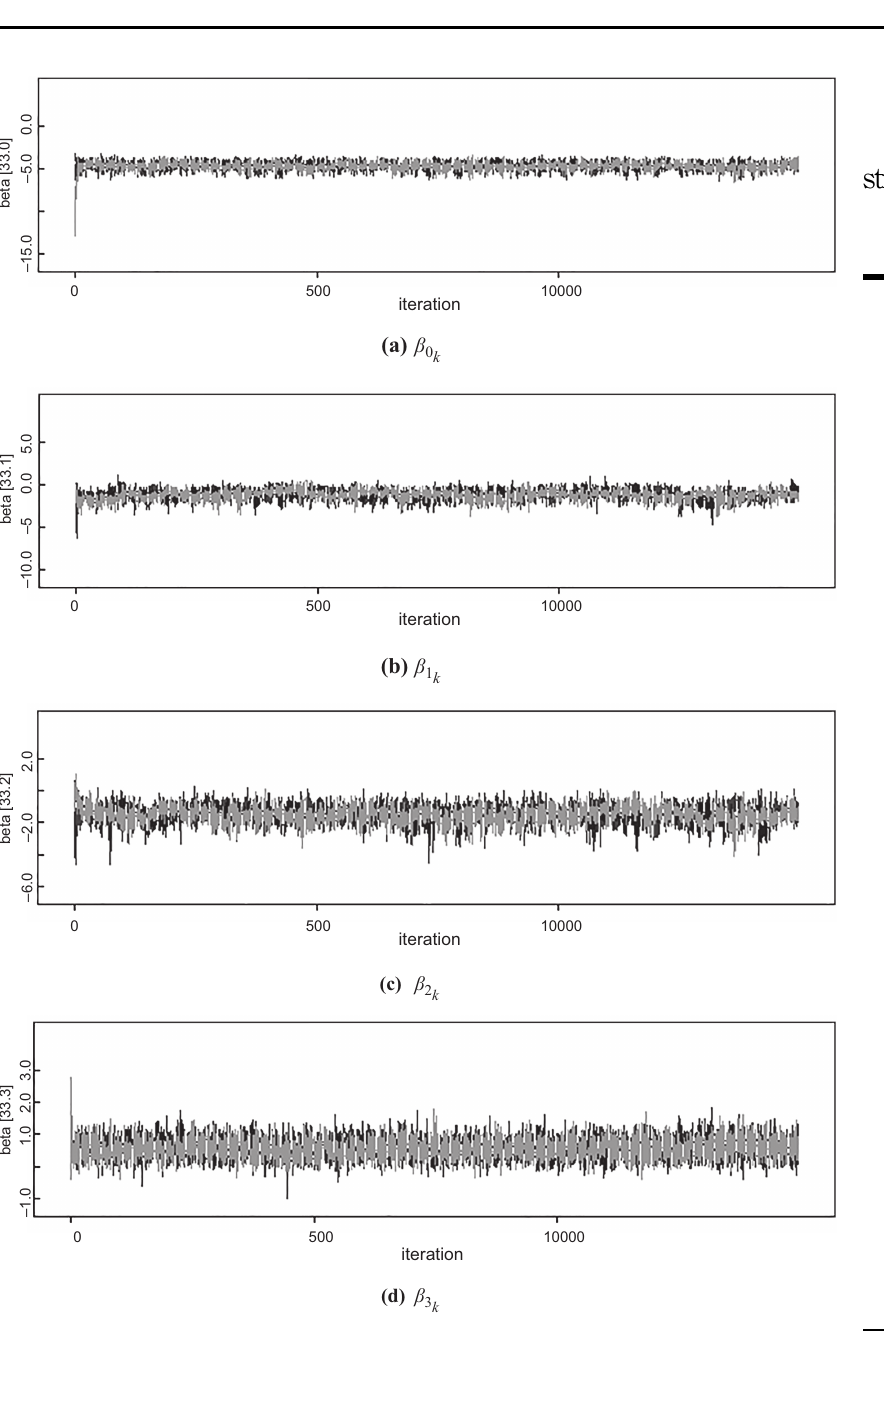
Figure 2. History plots